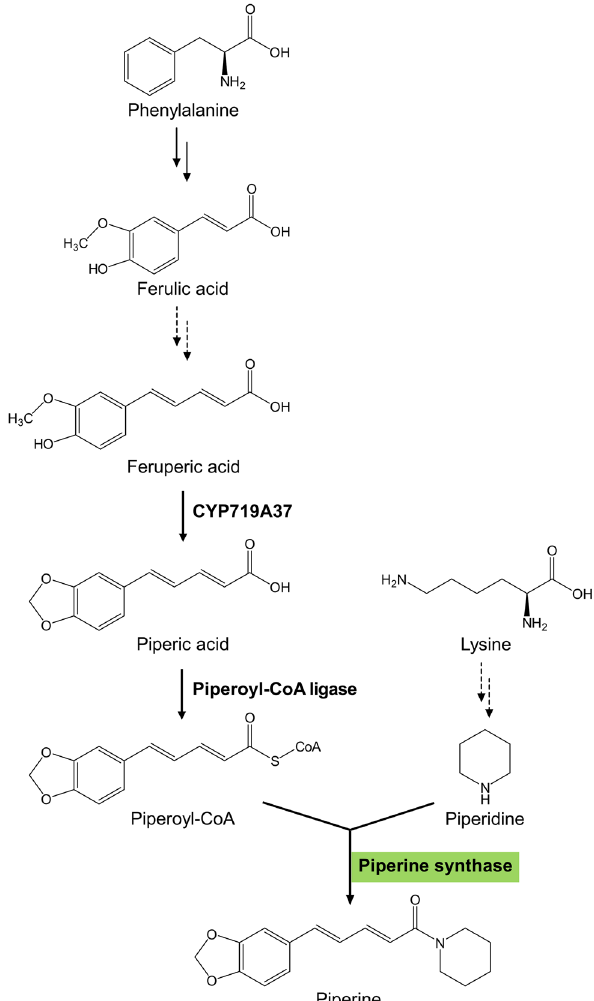
Fig. 1 Partly hypothetical pathway of piperine biosynthesis in black pepper fruits. The aromatic part of piperine is presumably derived from the phenylpropanoid pathway, whereas the formation of the piperidine heterocycle appears synthesized from the amino acid lysine. Double and dashed arrows mark either several or unknown enzymatic steps, respectively. Recombinant CYP719A37 and piperoyl-CoA ligase catalyze steps from feruperic acid to piperic acid and to piperoyl-CoA subsequently 15,16 . Piperine synthase, identi fi ed and functionally characterized in this report, is highlighted in gray and catalyzes the terminal formation of piperine from piperidine and